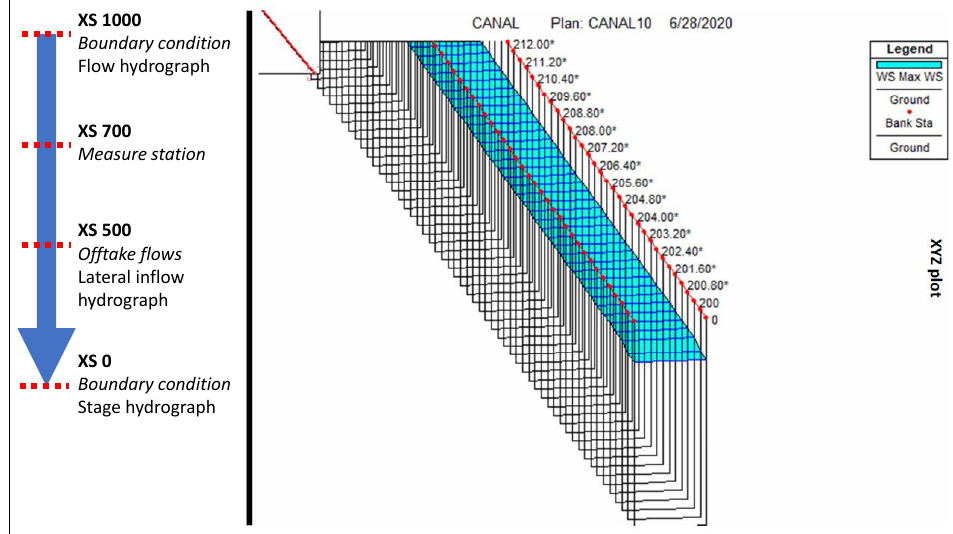
Figure 4. Schematic representation of the geometry of a simple rectangular